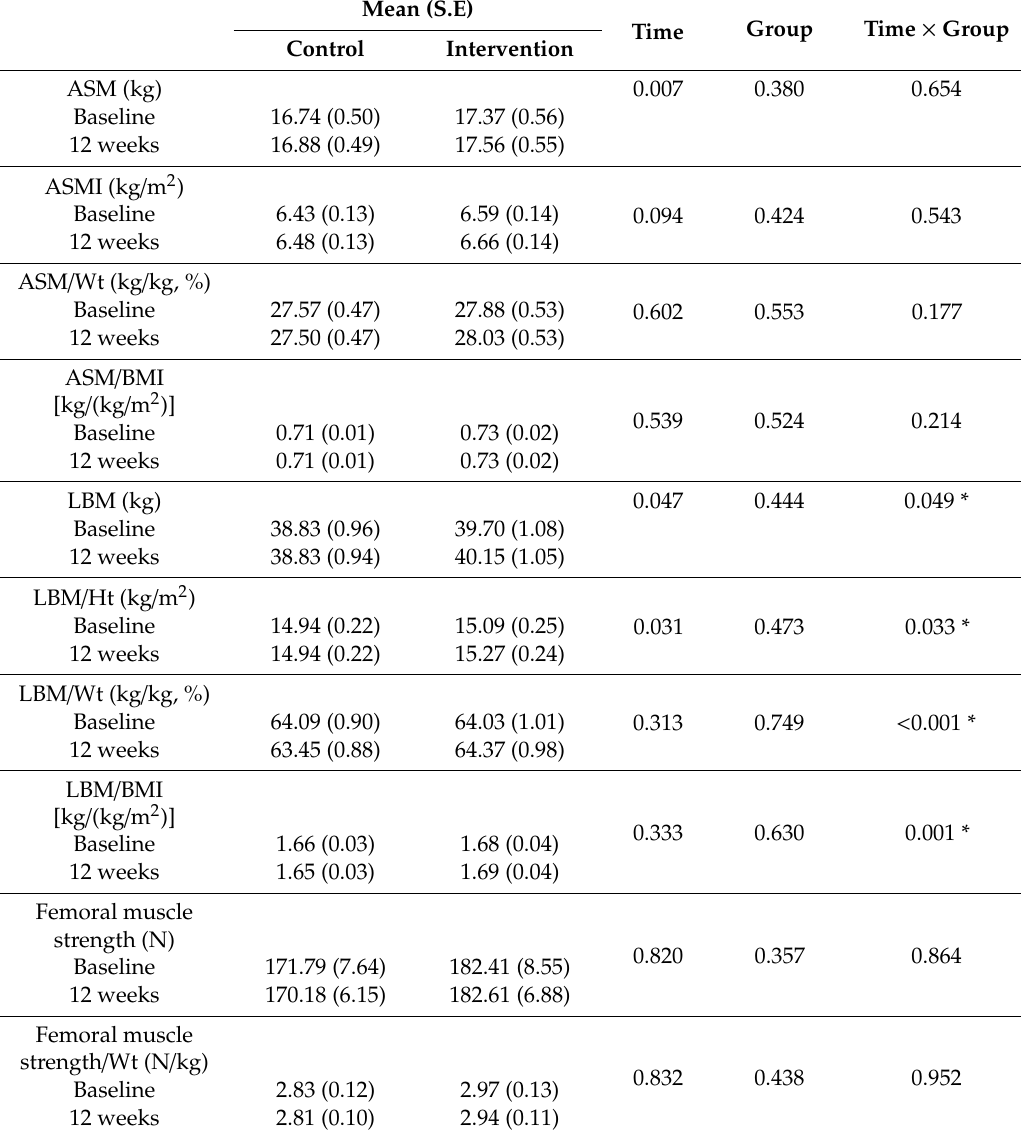
Table 5. Muscle health during the 12-week study period in participants aged 50–64 years (n =